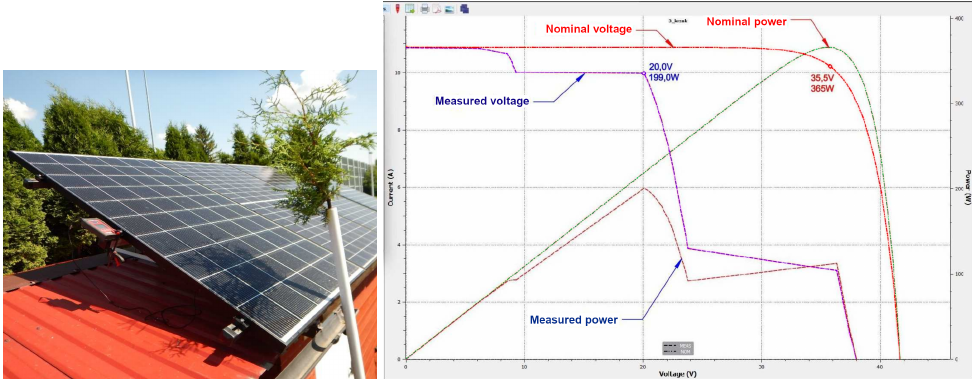
Figure 5. Shading PV module with a simple model of vegetation ( left inset ) and the I–V curve of the whole module ( right inset